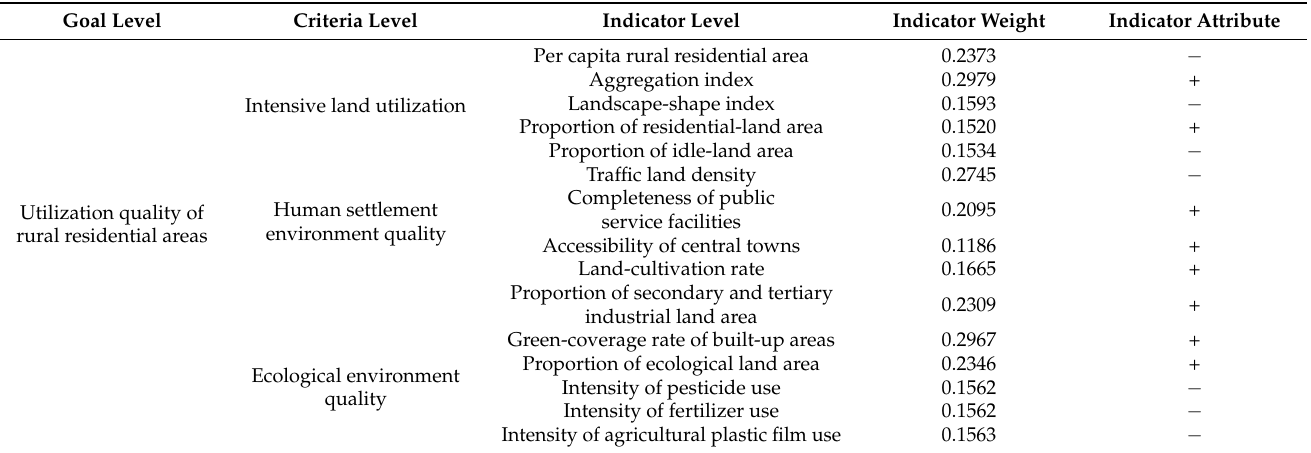
Table 1. Evaluation index system of utilization quality of rural residential